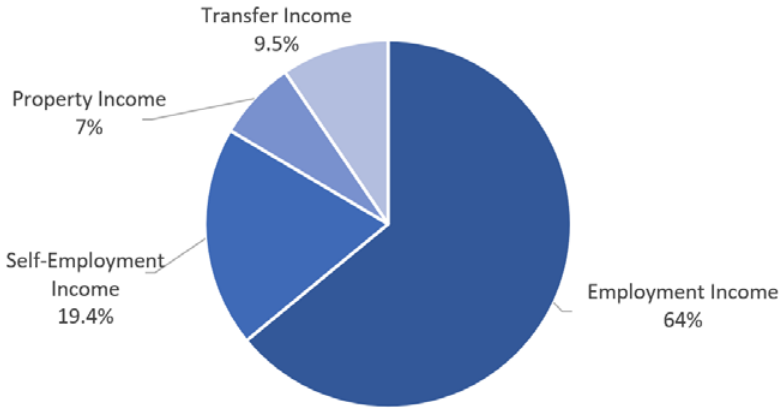
Figure 11. Share of gross household income by source (2019). Source: Statistics Korea [40].